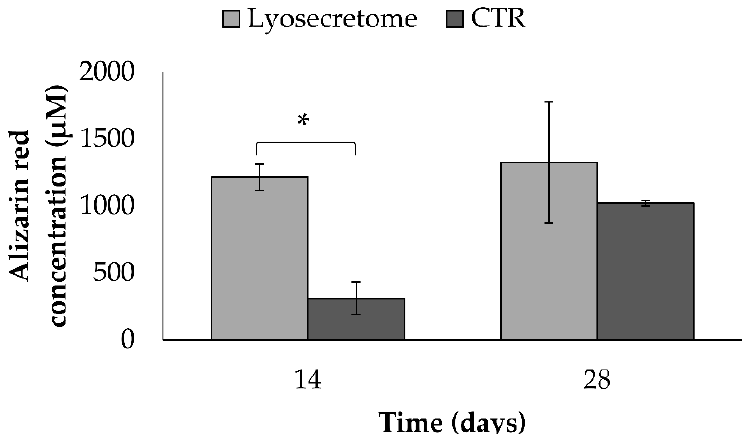
Figure 4. Alizarin red staining for samples cultured in osteogenic differentiation medium with Lyosecretome or without (CTR) for 14 and 28 days. Multifactor ANOVA (time and treatment, mean values ± LSD, n = 3) was used. * p < 0.001.